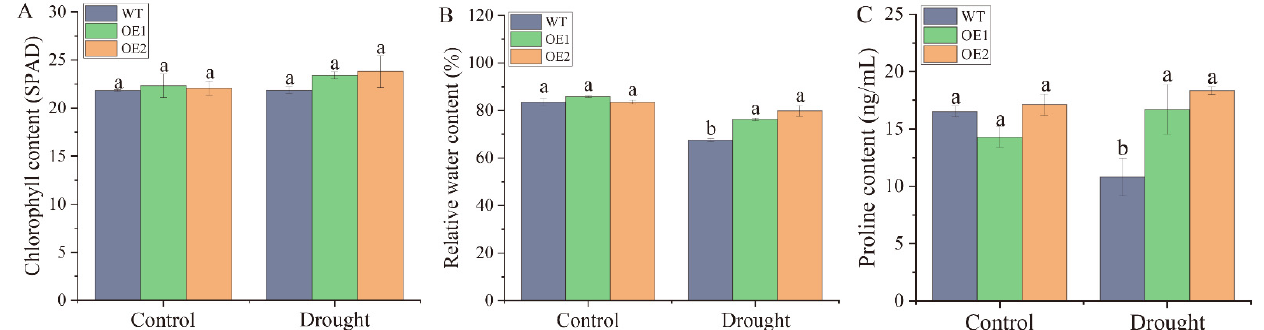
Figure 7. Contents of chlorophyll, relative water and proline in transgenic Nicotiana benthamiana plants overexpressed the ScDREB2B-1 gene under drought stress for 2 d. ( A ) Chlorophyll content. ( B ) Relative water content. ( C ) Proline content. WT: wild-type N. benthamiana . OE1 and OE2: different transgenic N. benthamiana lines overexpressed ScDREB2B-1. All data points were means ± standard error ( n = 3). Significant differences were found between different letter substitutes on the column calculated by Duncan’s new multiple range test ( p -value < 0.05).